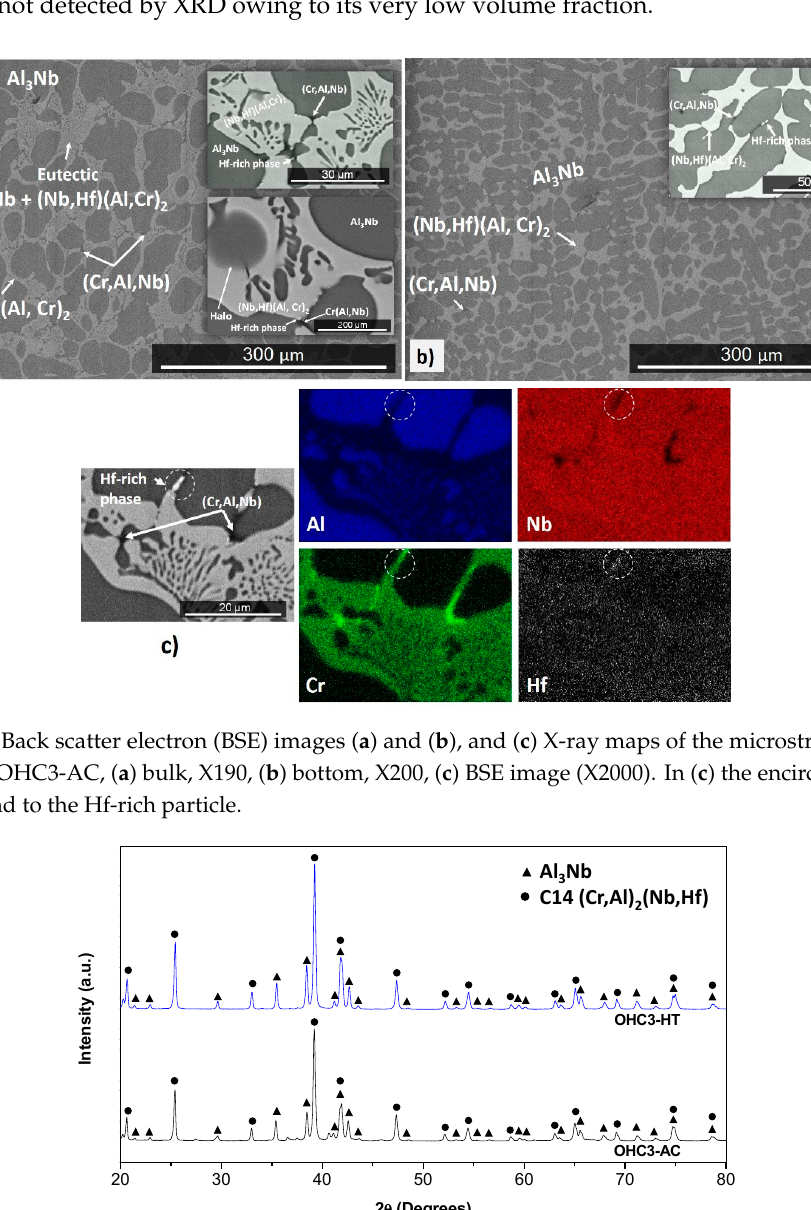
phase-46.1(0.8)Al-32.1(0.6)Nb-20.6(0.9)Cr-1.1(0.2)Hf, solid solution-45.4(0.8)Al-7.3(1)Nb-46.7(1.6)Cr-